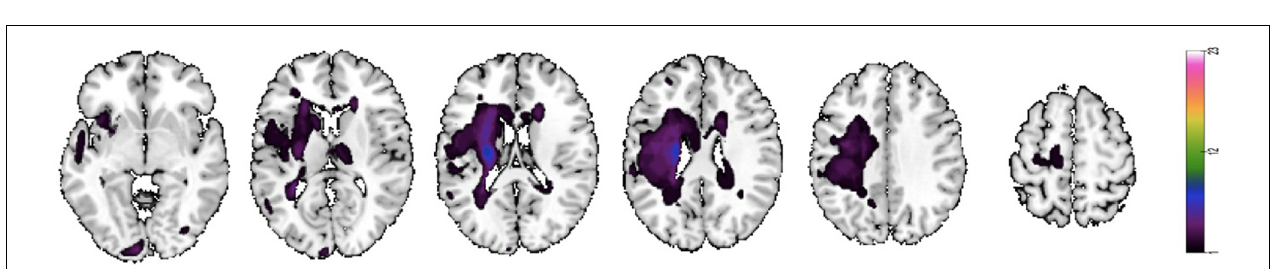
FIGURE 1 | Schematic diagram of fMRI experimental paradigm. The arrow pointing to the left in task 3 prompts subjects to imagine the activity of grasping with the left hand. The arrow towards to the right in task 4 prompts imagery of grasping with the right hand.